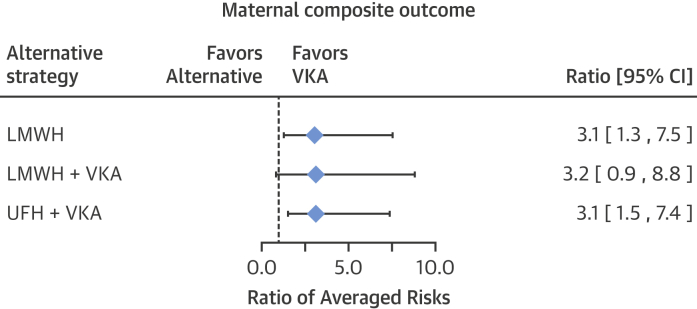
Maternal Composite OutcomeRatio of the meta-analytic averaged risk for the maternal composite outcome between a VKA regimen and each alternative regimen. Abbreviations as in Figures 1 and 2.